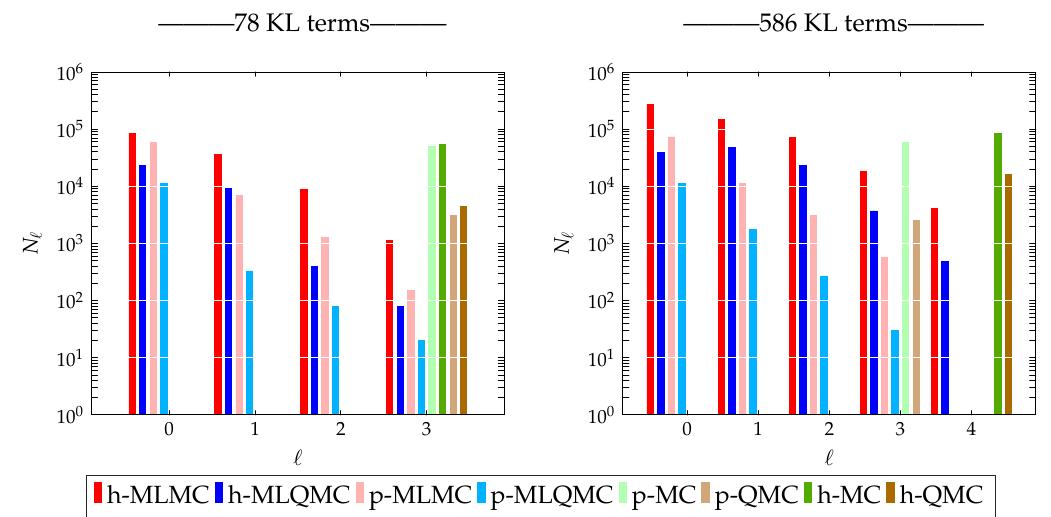
Figure 17. Number of samples for the different methods for model problem 1.